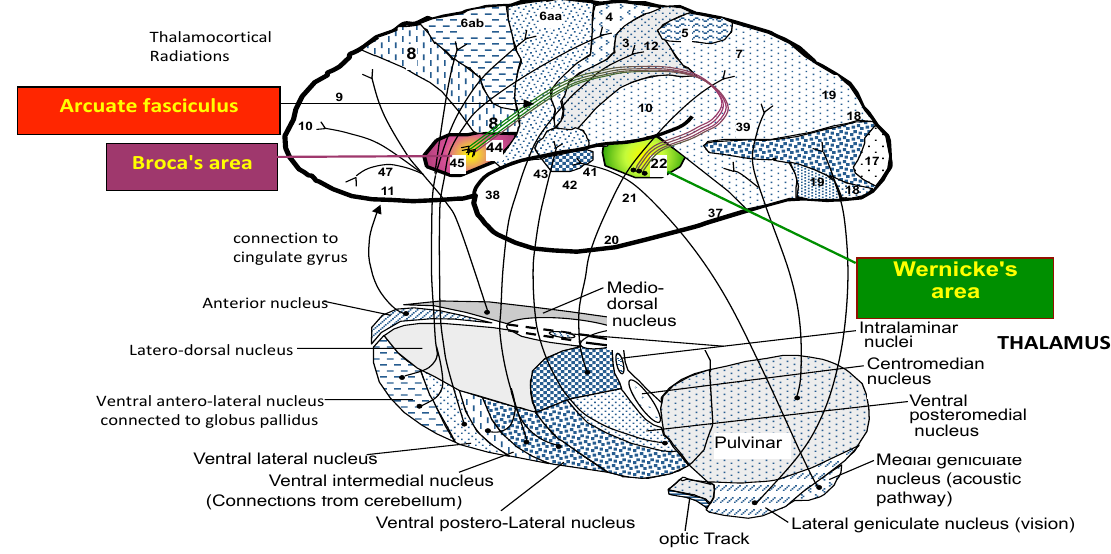
Figure 16. The brain, language area and thalamic connections